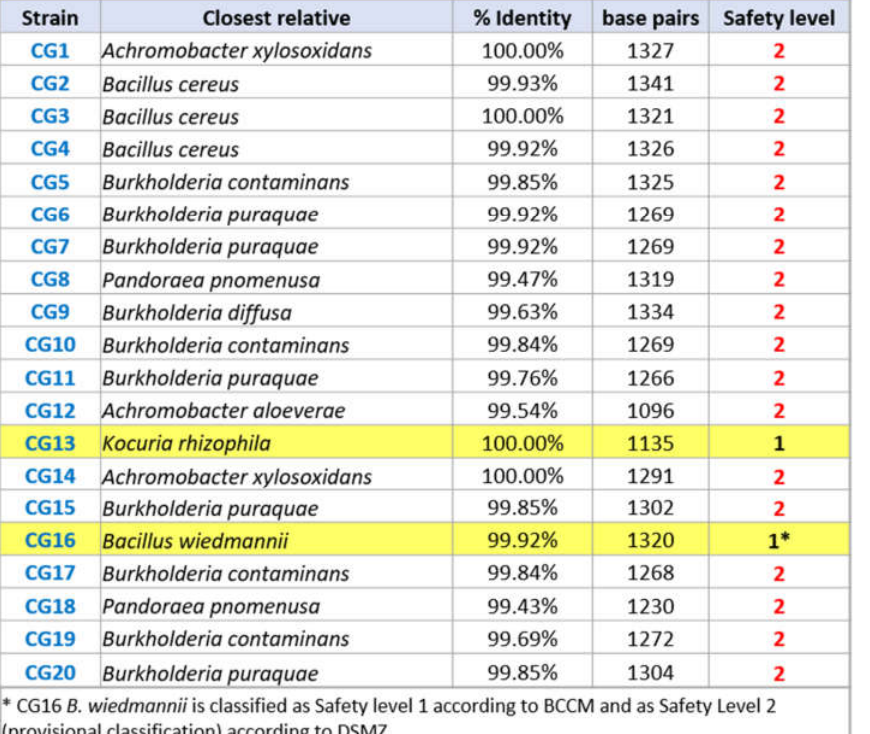
Figure 2. List of the 20 isolated strains. Biological safety levels (according to three different database: